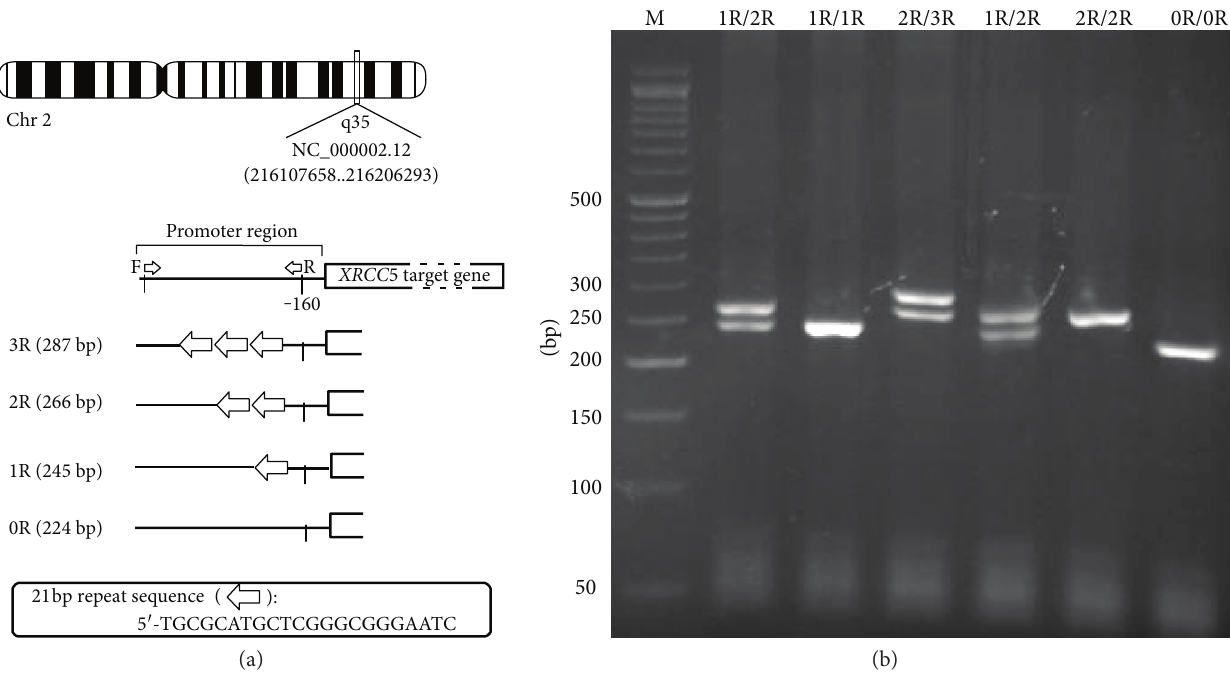
Figure 1: Schematic and PCR products of the XRCC 5 VNTR: (a) schematic diagram of the XRCC5 gene showing the position of the VNTR polymorphism along with various alleles; (b) PCR products containing XRCC5 VNTR with various